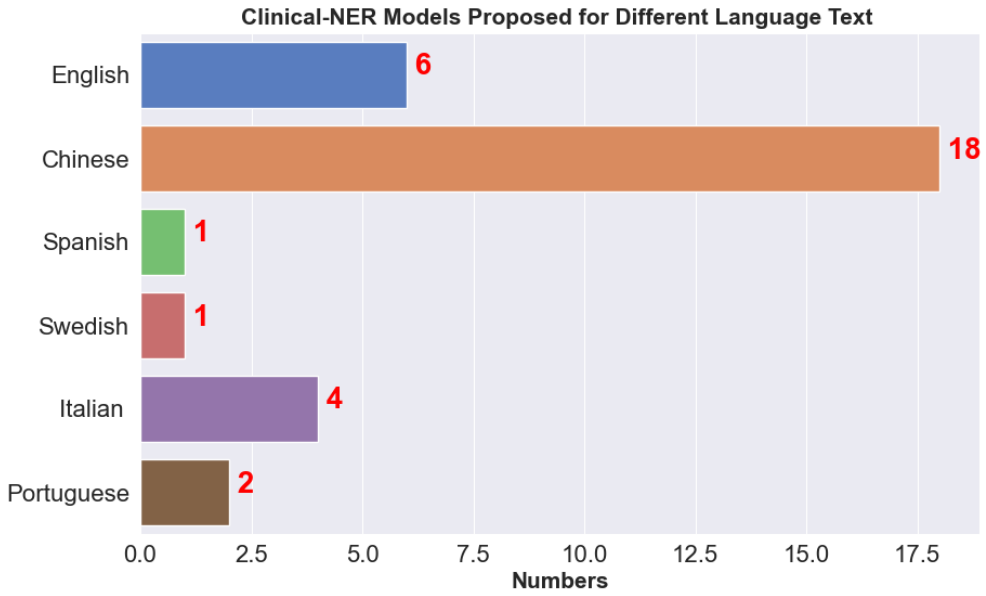
Figure 5. Clinical NER models available for text in different